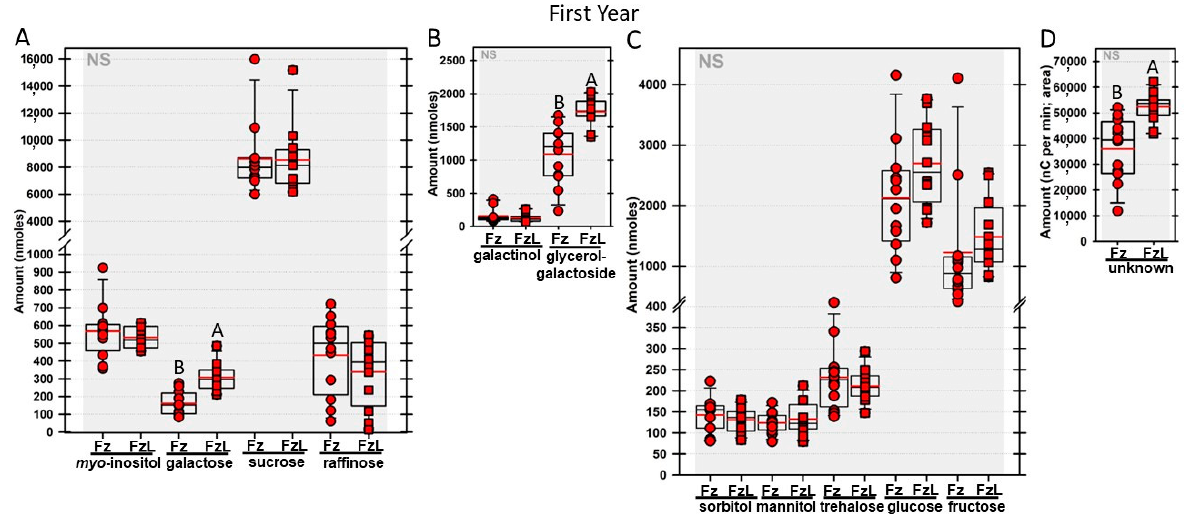
Figure 4. Amounts of soluble carbohydrates from null segregant maize leaf disks sampled in year 1. Carbohydrates were analyzed and quantified from null segregant (NS) maize leaves that were frozen after harvest (Fz; red circles) or were frozen and then lyophilized to dryness (FzL = frozen lyophilized; red squares). For each carbohydrate, the box and whisker plot depicts the mean (red bar) and median (black bar), with the box capturing the interquartile range (25th to the 75th percentile), the whiskers signify the 10th to the 90th percentile, and outliers are dots beyond these whiskers, if any. For carbohydrate amounts (nmoles) from the same-sized disks, different uppercase letters over the box plots between frozen and lyophilized tissues denote statistically significant differences between treatments (ANOVA, Scheffe’s multiple comparison test, α = 0.05). ( A ): myo -inositol; galactose; sucrose and raffinose. ( B ): galactinol and glycerol–galactopyranoside. ( C ): Sorbitol; mannitol; trehalose; glucose, and fructose. ( D ): Area under the curve for unknown 2.